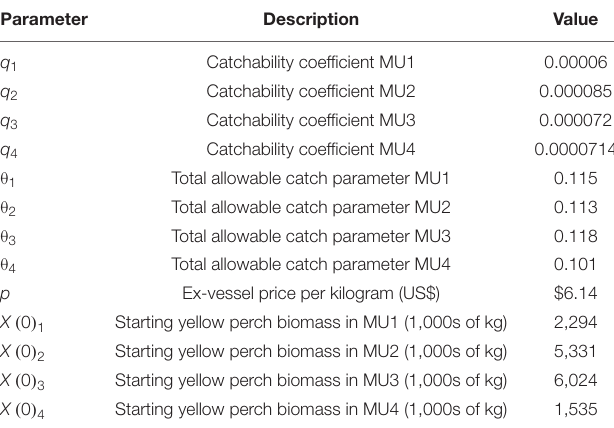
TABLE 1 | Parameter values used in the bioeconomic model